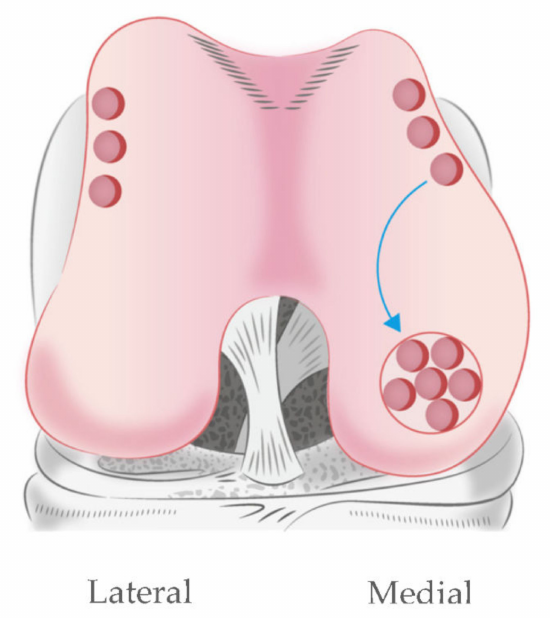
Figure 9. Mosaicplasty at the medial femoral condyle using autologous osteochondral plugs. The donor site is a non-weight-bearing area of distal femur at the medial and lateral edges of the femoral